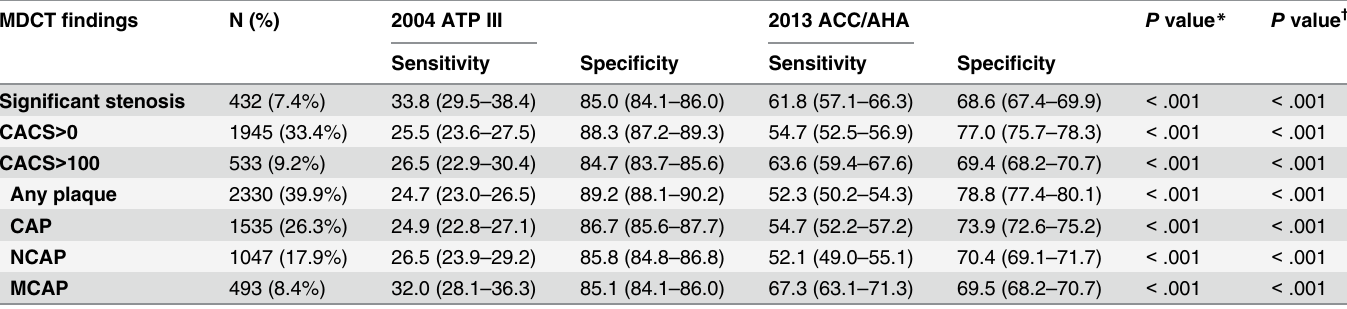
Table 3. Diagnostic characteristics of the 2004 ATP III and 2013 ACC/AHA guidelines in assigning statin therapy in subjects with subclinical coro- nary atherosclerosis.